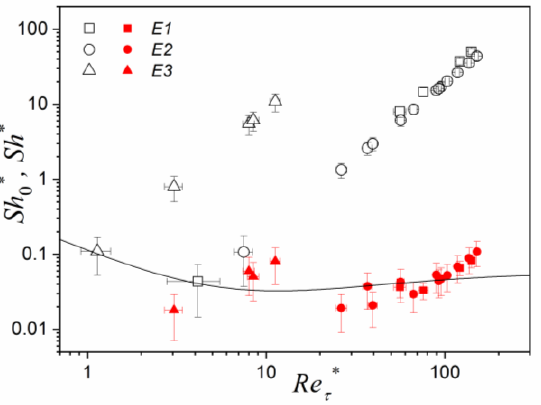
Fig. 1. Onset values of both the usual 𝑺𝒉 𝟎∗ (black open symbols) and the extended 𝑺𝒉 ∗ (red closed symbols) Shields numbers as a function of the critical particle shear Reynolds number 𝑹𝒆 𝝉∗ deduced from the experiments [11]. The solid line stands for the so-called Shields curve [2].